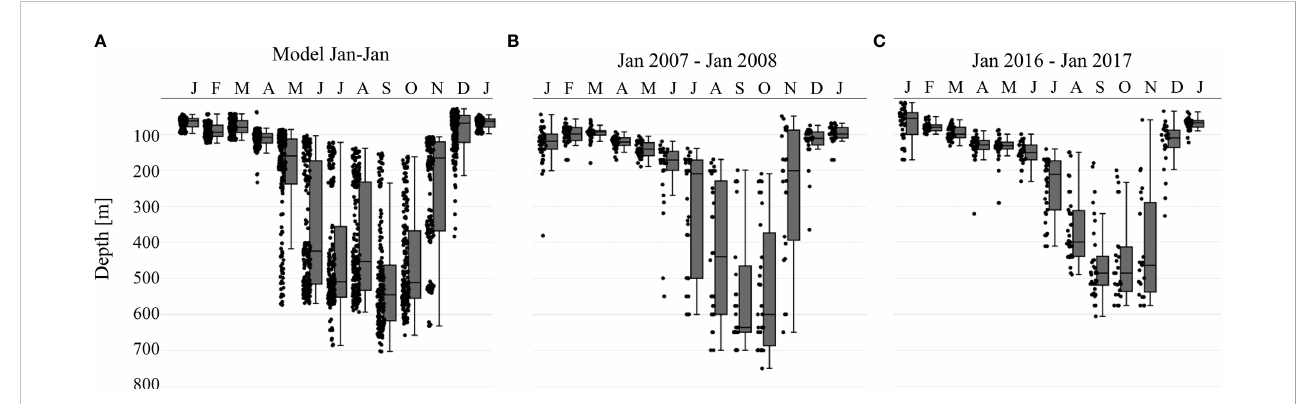
FIGURE 5 Boxplot of mixed layer depths from (A) Monterey and Levitus, 1997 database, (B) January 2007 to January 2008 calculated from Argo data, and (C) January 2016 to January 2017 calculated from Argo data. The position of the points on x-axis is trivial within each month.